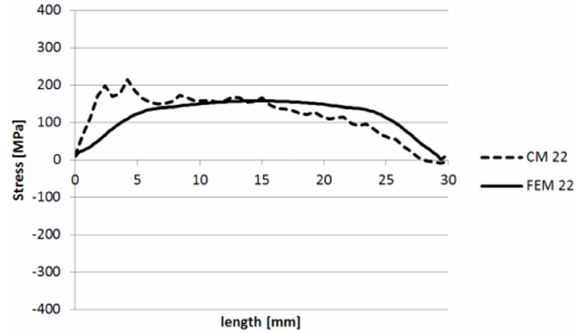
Figure 41. Stress levels in 22 direction along the AB line segment.